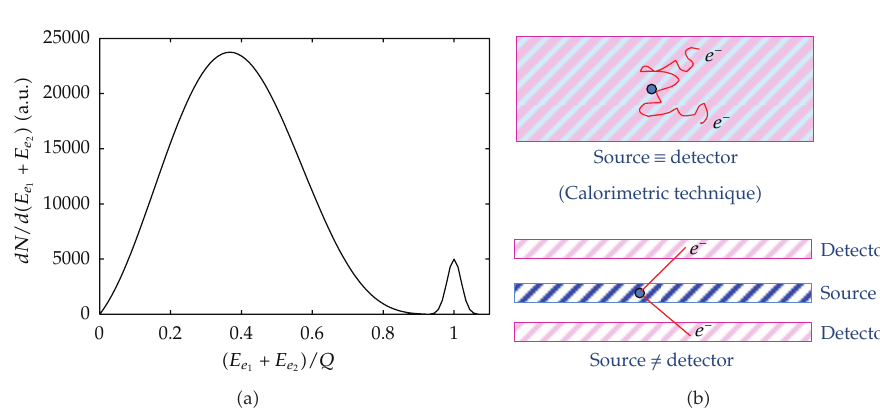
Figure 10: (cid:2) a (cid:3) Distribution of the sum of the two electron energies for 0 νββ and 2 νββ , obtained assuming that the 2 νββ rate is 100 times faster than the 0 νββ , and the FWHM detector energy resolution is 5%. (cid:2) b (cid:3) Schematic representation of the calorimetric technique and of the external source approach.